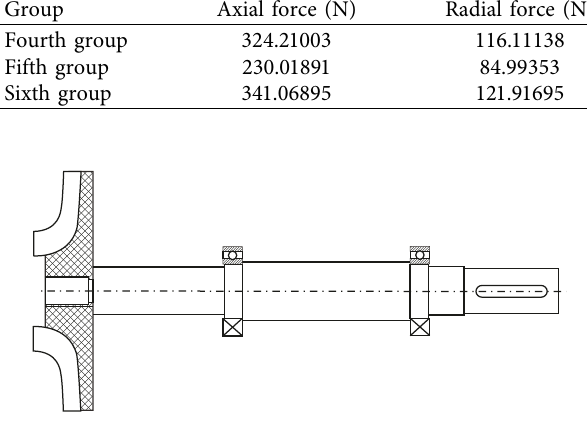
Figure 20: Structure diagram of the pump shaft